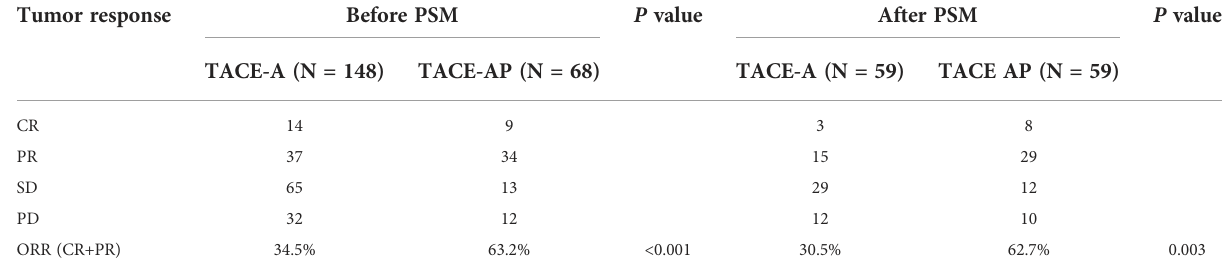
TABLE 2 Tumor response before and after PSM analysis. Tumor response